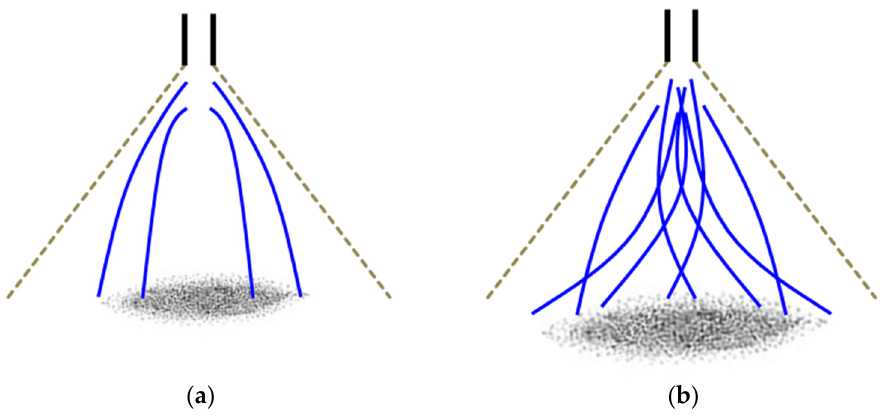
Figure 1. Expected trajectory of spray for ( a ) commercial nozzle and ( b ) developed nozzle.